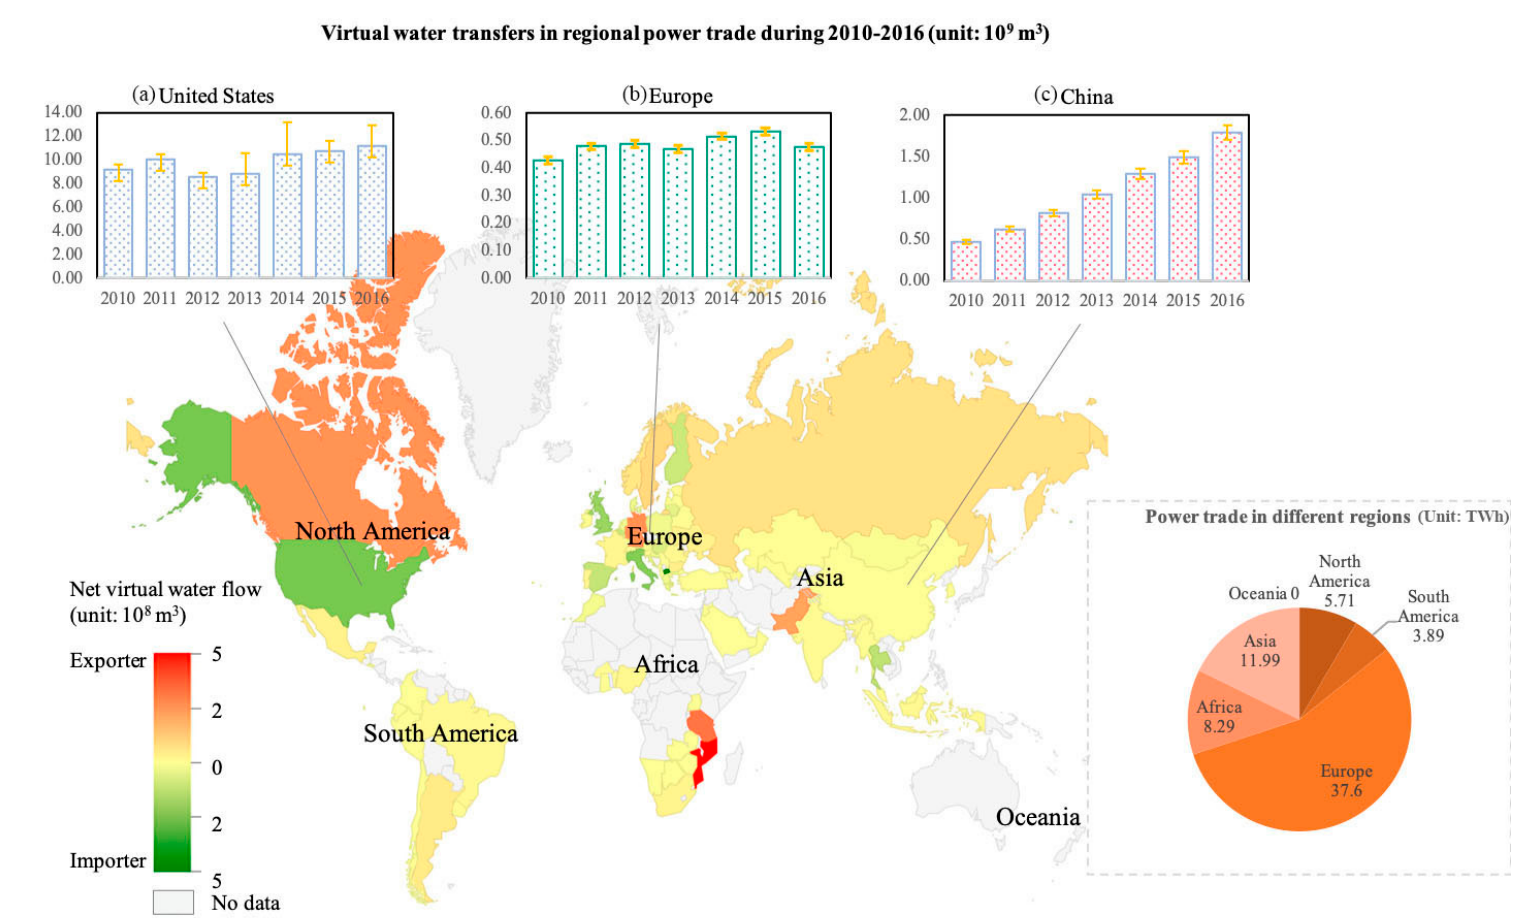
Figure 6. The global virtual water flow of power trade in 2017 (the power trade data are extracted from the United Nations database [29], and the virtual water flows are estimated using the water footprints provided by [3]); virtual water transfers of regional power trade during 2010–2016. Virtual water transfers in the United States [63] and Europe [62] are calculated by the direct trade-adjustment method, and the Node-Flow method is used for virtual water transfers in China [64]. Callouts: trends of the virtual water flows with time ( a ) the United States, ( b ) Europe, ( c ) China.